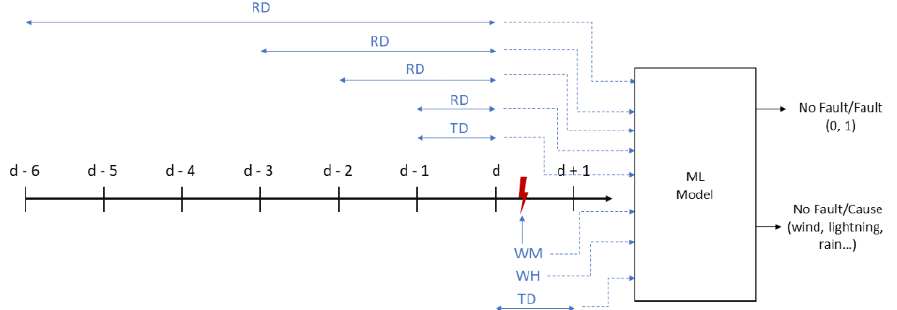
Figure 6. Timeline for selection of the 4 groups of weather variables approaching a fault occurrence classification (d is the day of each fault or no fault example). The codes RD, TD, WM and WH correspond to subsets of the weather variables shown in Table 3. Each group includes the following variables. RD: 1–4, TD: 5–8, WM: 9–12 and WH: